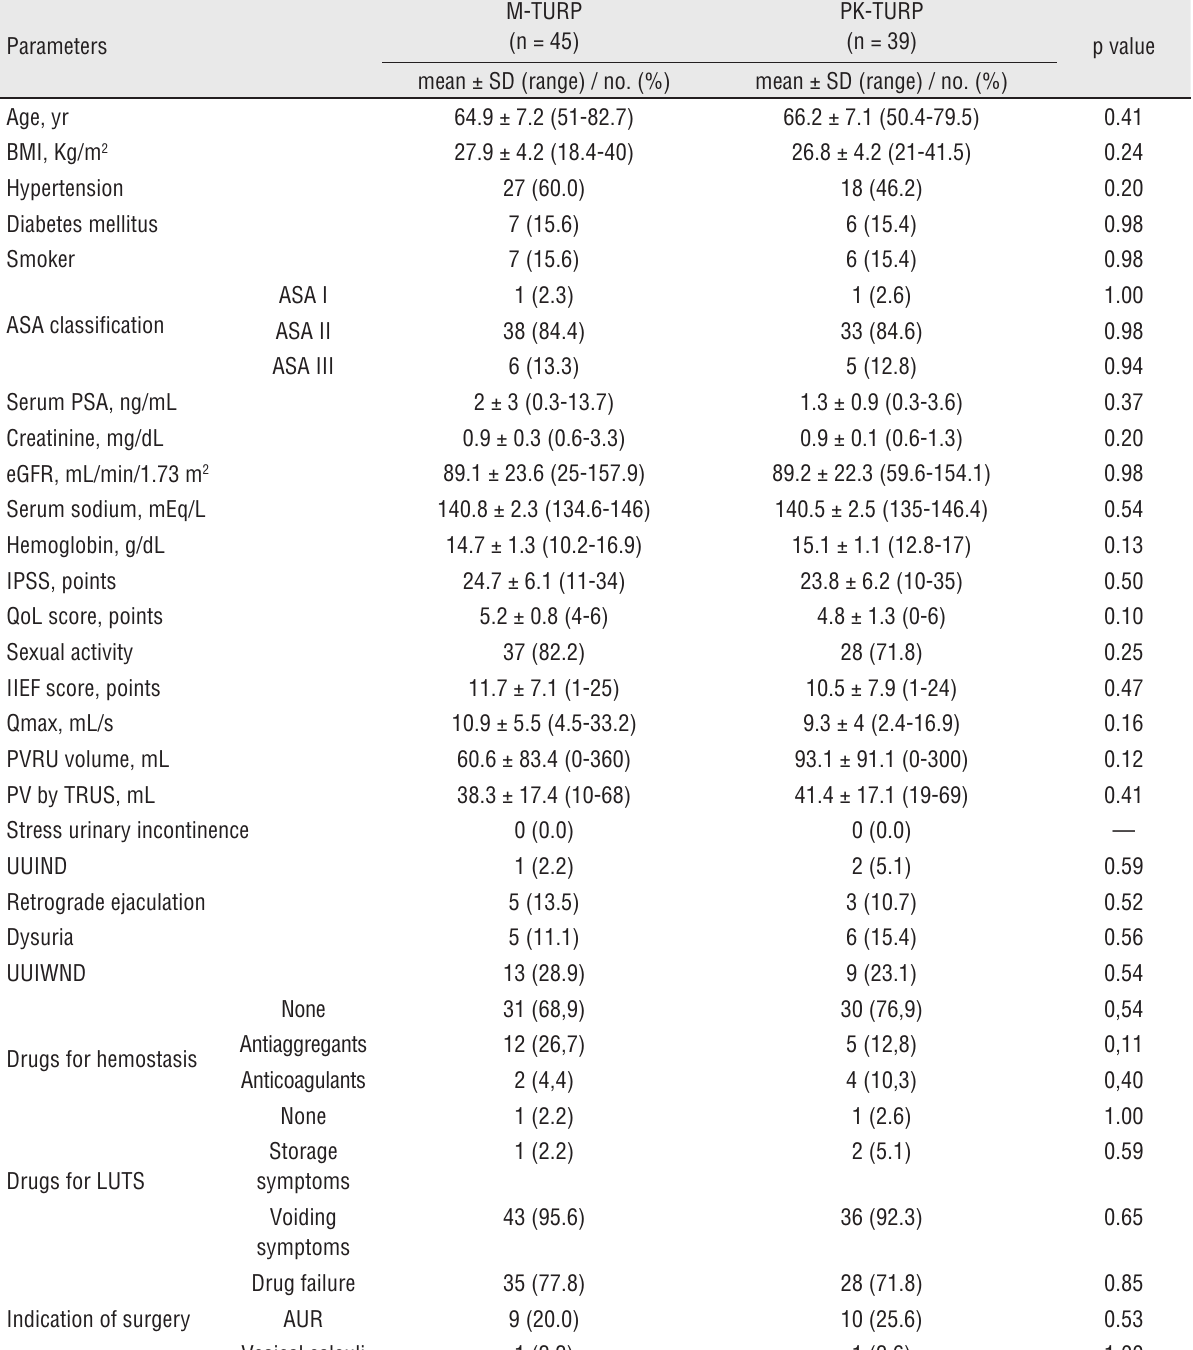
Table 1 - Baseline characteristics of eligible